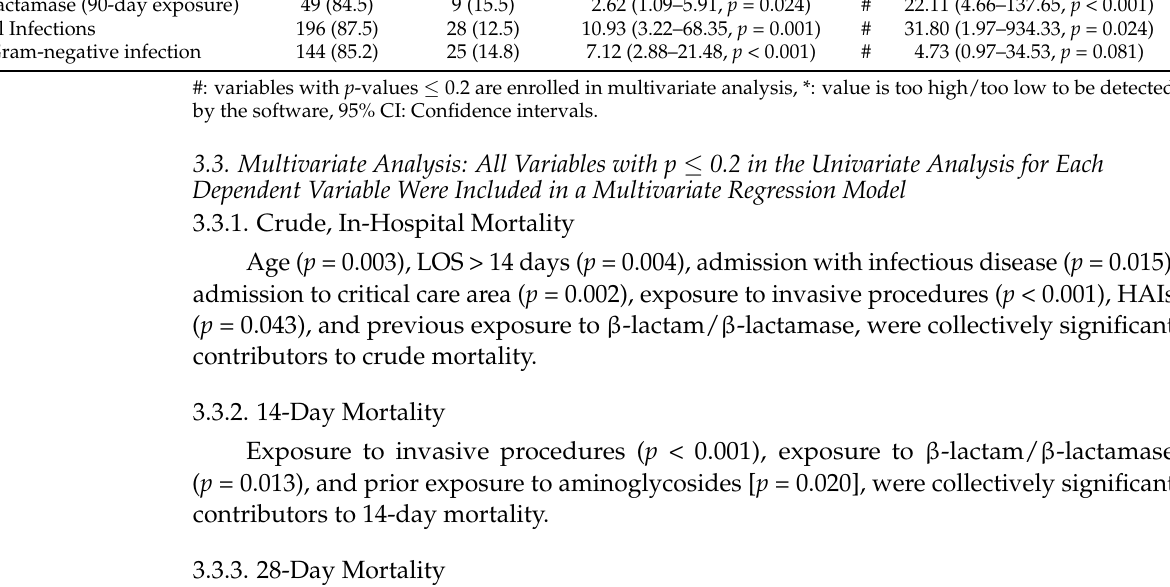
Table 5. Treatment outcomes Vs. Antimicrobial treatment regimen (Binary logistic regression).